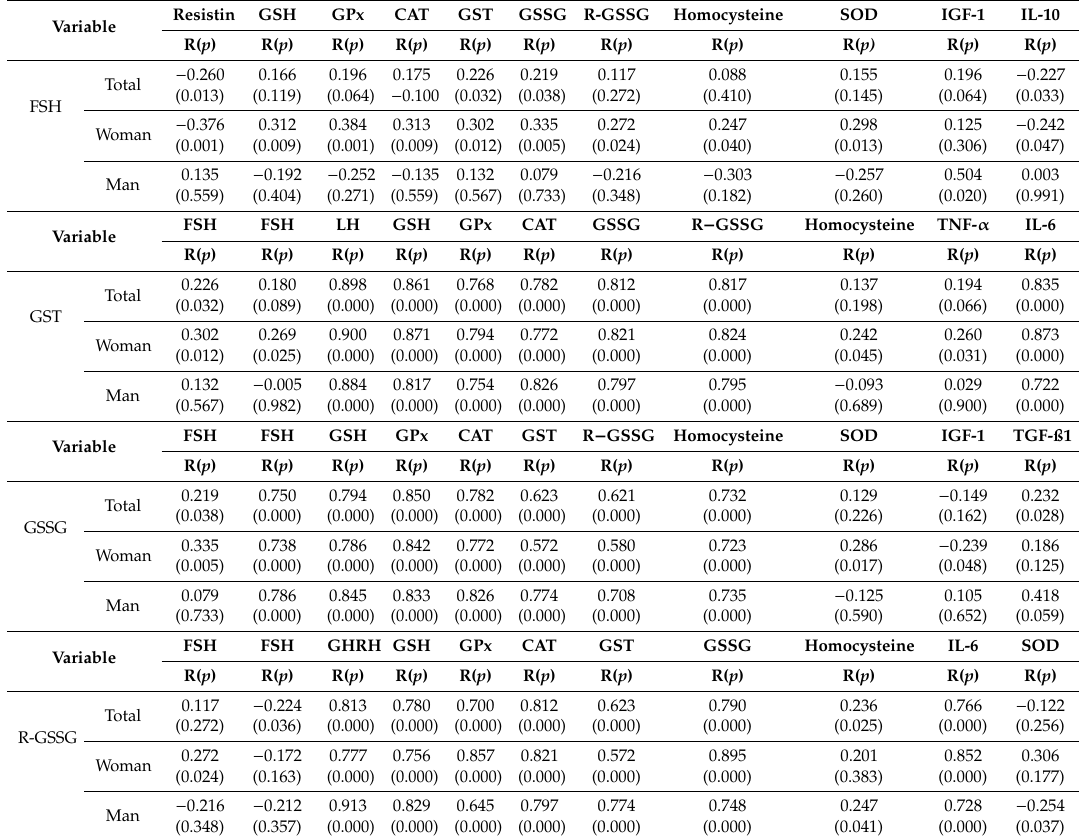
Table 7. The Spearman rank correlation analysis for follicle-stimulating hormone (FSH), glutathione S-transferase (GST), oxidized glutathione (GSSG) and glutathione reductase (R-GSSG), including selected variables in the general group, men and